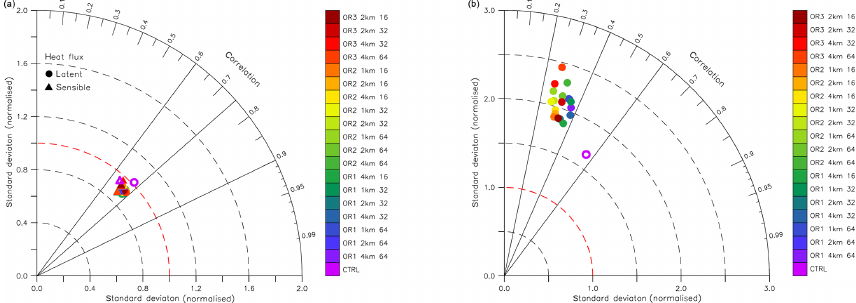
Figure 9. Global Taylor diagrams of sensible and latent heat fluxes (a) and cloud optical thickness (b) over land points only. The control sim- ulation is marked with open purple–white symbols. For comparison purposes, reanalysis data of NCEP are taken to compare all simulations with respect to heat fluxes, and MODIS retrievals provide estimates of cloud optical